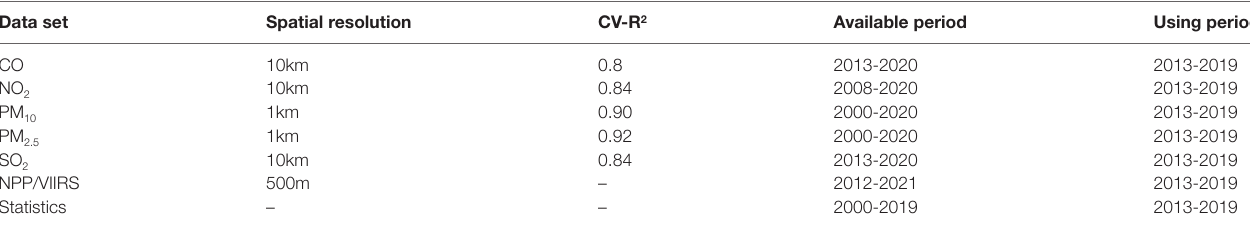
TABLE 1 | Summary of data